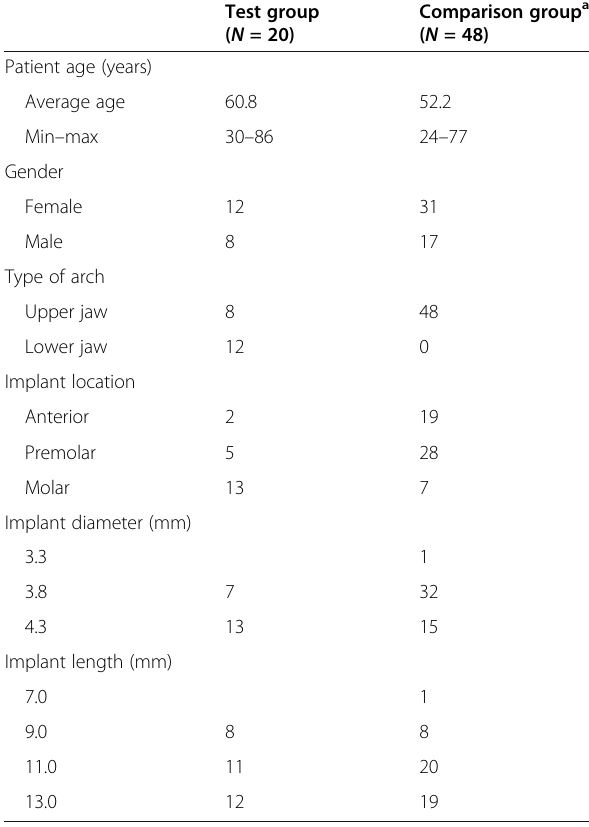
Table 1 Demographics of the patients and distribution of the implants